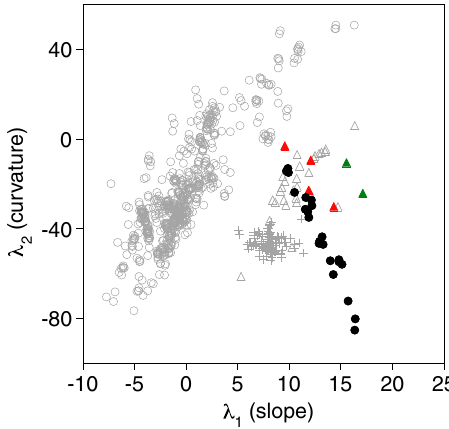
Fig. 2 The curvature ( λ 2 ) and slope ( λ 1 ) of the rare earth element (REE) patterns of basaltic melts. The λ 2 and λ 1 of the REE patterns of ocean fl oor basalts (open circles 10 ), Hawaiian shield tholeiites (crosses 13 ), melts from Loihi (triangles 14,15 , including alkalic basalts (red) and basanites (green) for which fractionation of garnet has been suggested 15 ), and the pre-shield Kilauean basanite-nephelinite glasses of this study